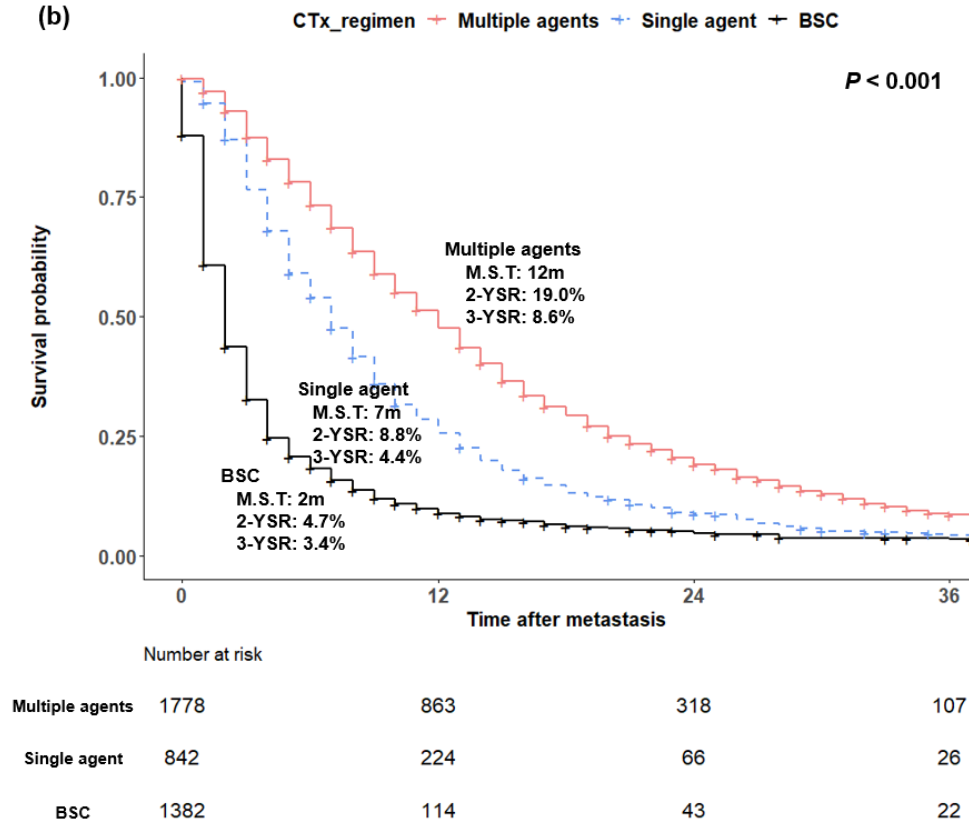
Figure 5. ( a ) Kaplan − Meier analysis of pancreatic ductal adenocarcinoma patients with isolated lung metastasis from the National Cancer Database according to treatment options. ( b ) Kaplan − Meier analysis of pancreatic ductal adenocarcinoma patients with isolated lung metastasis from the Na- tional Cancer Database who did not undergo surgery according to a chemotherapy regimen. CTx., chemotherapy; BSC, best supportive care; M.S.T, median survival time; YSR, year survival rates. Table 2. Univariate and multivariate analysis regarding the factors influencing survival after the occurrence of